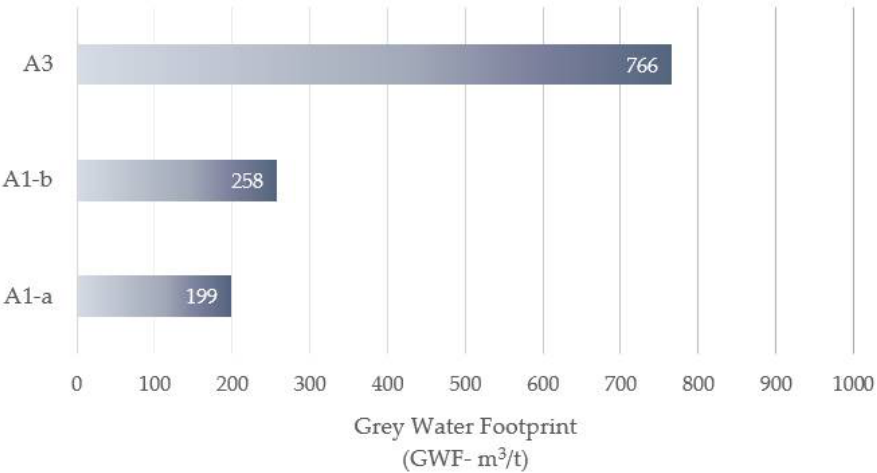
Figure 3. Grey water footprint (GWF) volume in barley crop during 2019 growing period using different calculation approaches. Leaching/runoff fraction approach (A1): A1-a: α = 10%, A1-b: α as a function of weather, soil and crop management factors; and N balance approach (A3). Surplus approach (A2) could not be applied for GWF estimation, because it estimated a negative contami- nant load (L = 0).